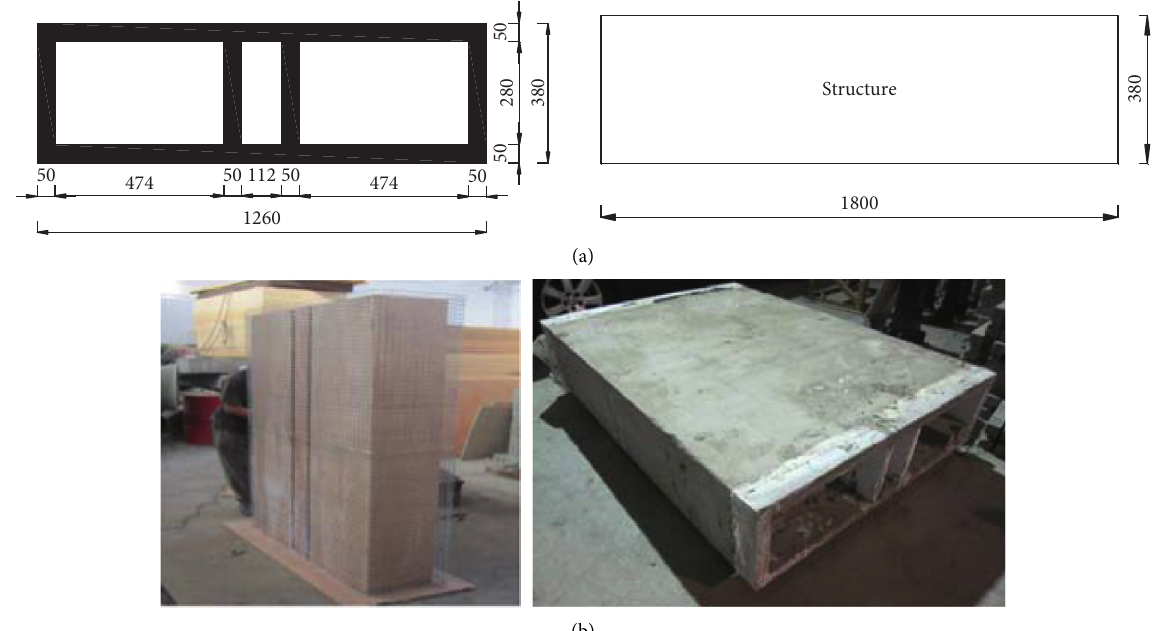
Figure 4: Test 4 structural model. (a) Dimensions of cross section and vertical section of rigid tunnel (mm). (b) Actual model of rigid tunnel.